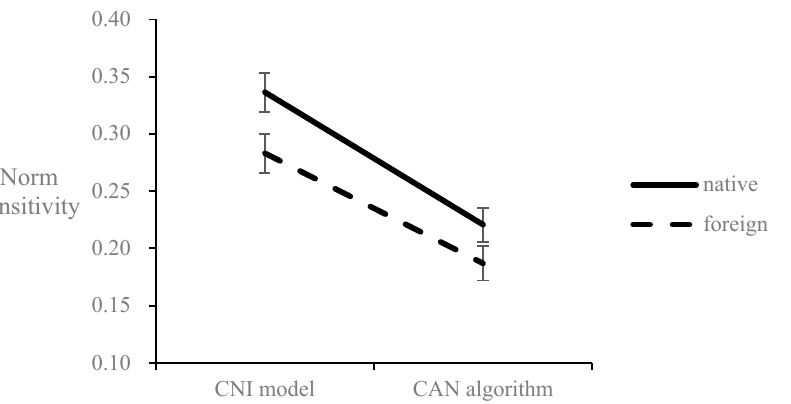
Figure 4. Norm sensitivity estimated by the CNI model and the CAN algorithm marginally interacts with the foreign/native language condition. Error bar represents the ±1 standard error.